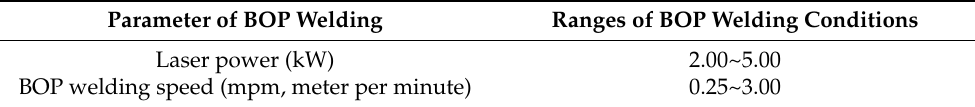
Table 3. Range of experimental BOP welding conditions.